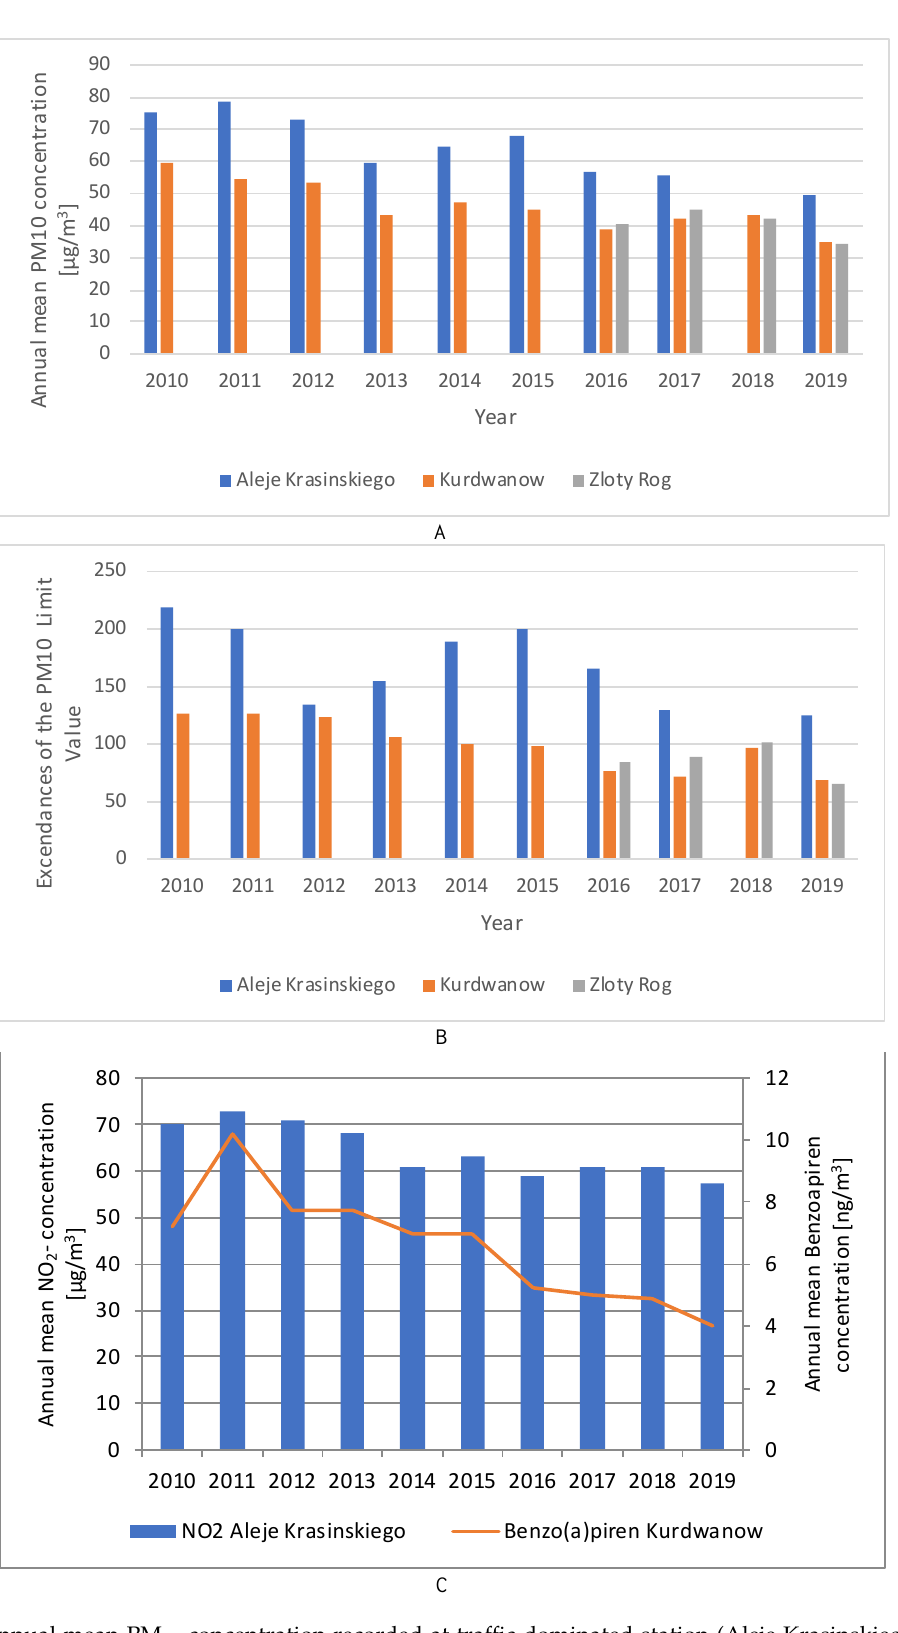
Figure 1. ( A ) Annual mean PM 10 concentration recorded at traffic-dominated station (Aleje Krasinskiego) and urban-background stations (Kurdwanow and Zloty Rog) during last decade. ( B ) Exceedances of the PM 10 limit value (50 µ g/m 3 ) at the same stations. ( C ) Annual mean concentration of NO 2 (in µ g/m 3 ) at traffic-dominated station (Aleje Krasinskiego) and Benzo(a)piren (in ng/m 3 ) at urban-background (Kurdwanow) stations. Data source: